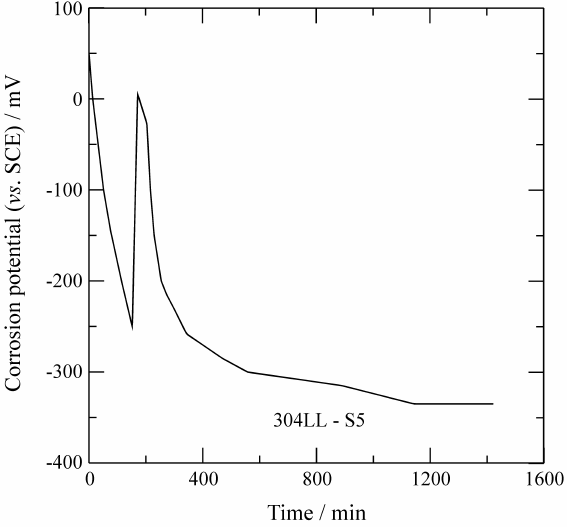
Figure 10. Corrosion potential E corr variation with immersion time in 3.5% NaCl solution for 304LL steel with S5 surface finish.